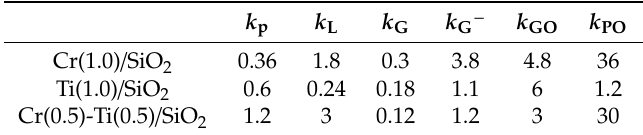
Scheme 3. Proposed reaction pathway for dihydroxyacetone transformation. Reproduced with permission from [46]; copyright (2019), Elsevier. Table 2. Rate constants for dihydroxyacetone (DHA) transformation using silica-supported chromium oxide, titanium oxide and chromium–titanium oxide catalysts (units in h − 1 ). Reproduced with permission from [46]; copyright (2019), Elsevier.